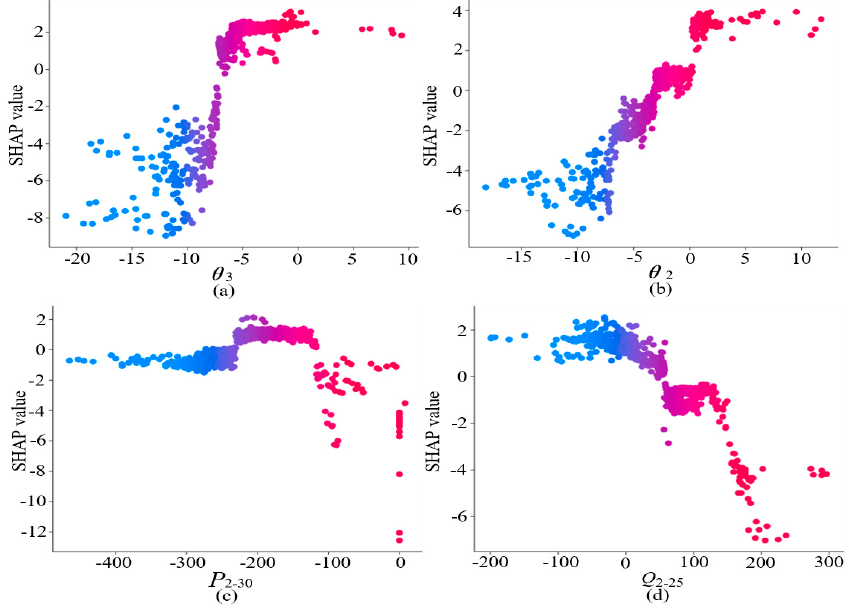
Figure 7. ( a ) SHAP dependence of θ 3 ; ( b ) SHAP dependence of θ 2 ; ( c ) SHAP dependence of P 2-30 ; ( d ) SHAP dependence of Q 2-35 .